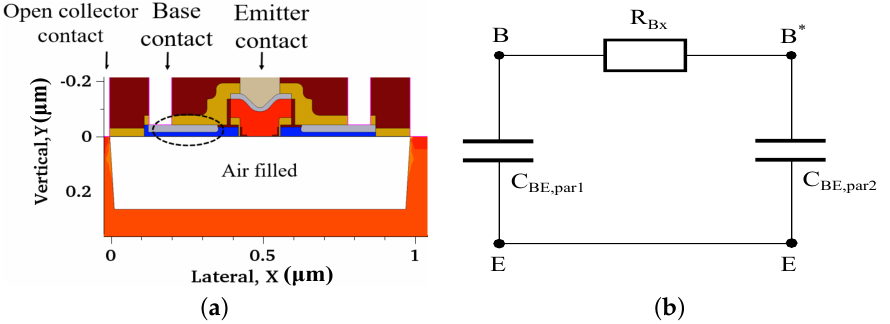
Figure 5. ( a ) Customized TCAD structure (gray: silicite, blue: p-type poly-Si) and ( b ) RC equivalent circuit representing the circled region in ( a ) for the determination of base-emitter parasitic capacitance partitioning factor ( fbepar ). Here, B is the external base